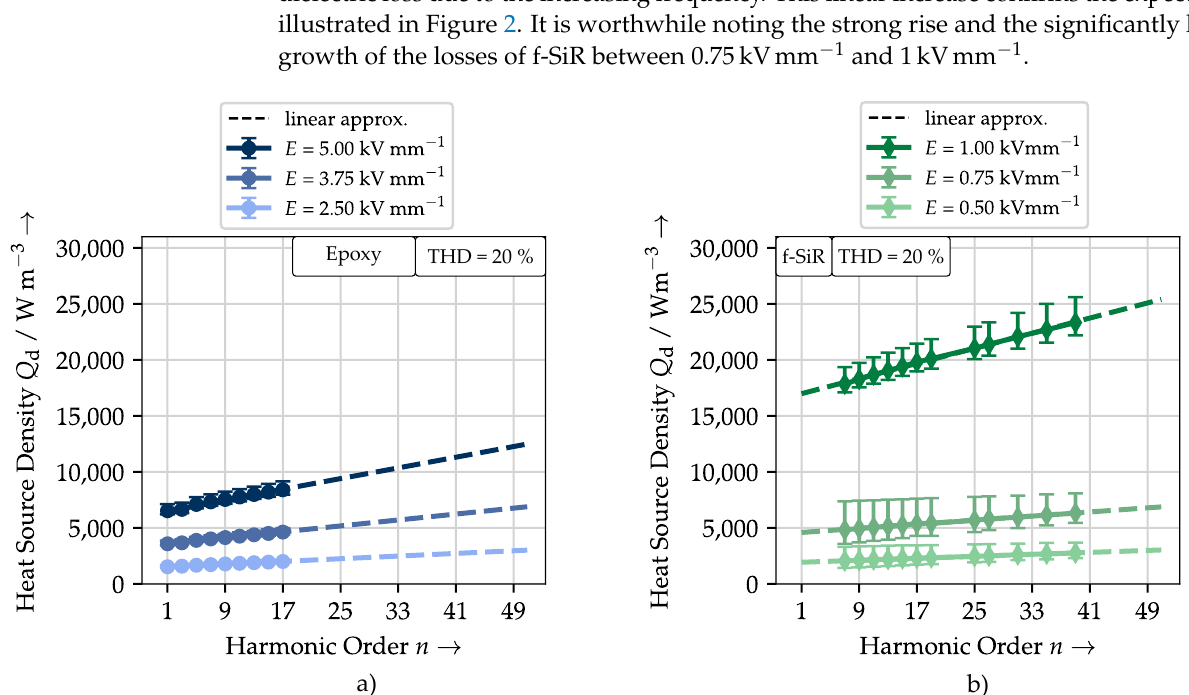
Figure 12. Heat source density as a function of the harmonic order n with a linear approximation. Results for different electrical field strengths E . ( a ) Epoxy polymer and ( b ) f-SiR, the mean and range of three test